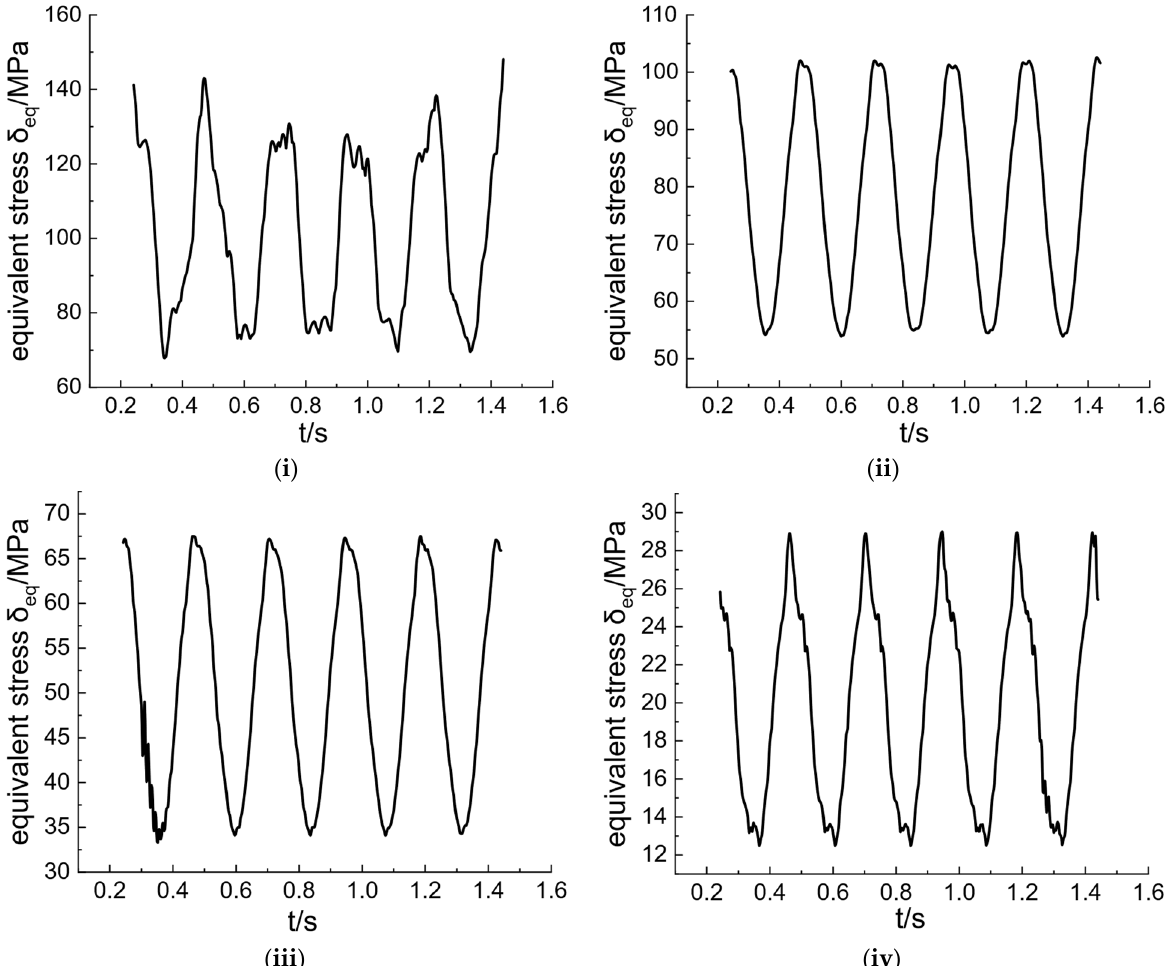
Figure 8. Stress curves of pump working conditions. ( i ) 0.6 Q, ( ii ) 0.8 Q, ( iii ) 1.0 Q, ( iv ) 1.2 Q.